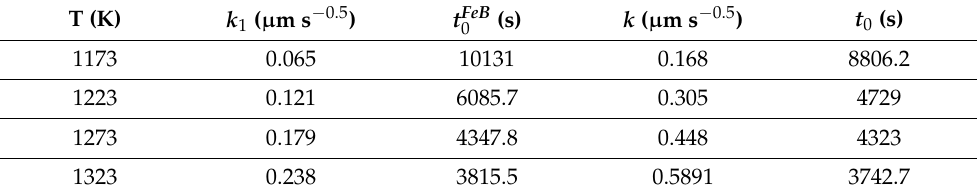
Table 1. Experimental kinetics constants for the two interfaces with the corresponding boride incubation periods [23].